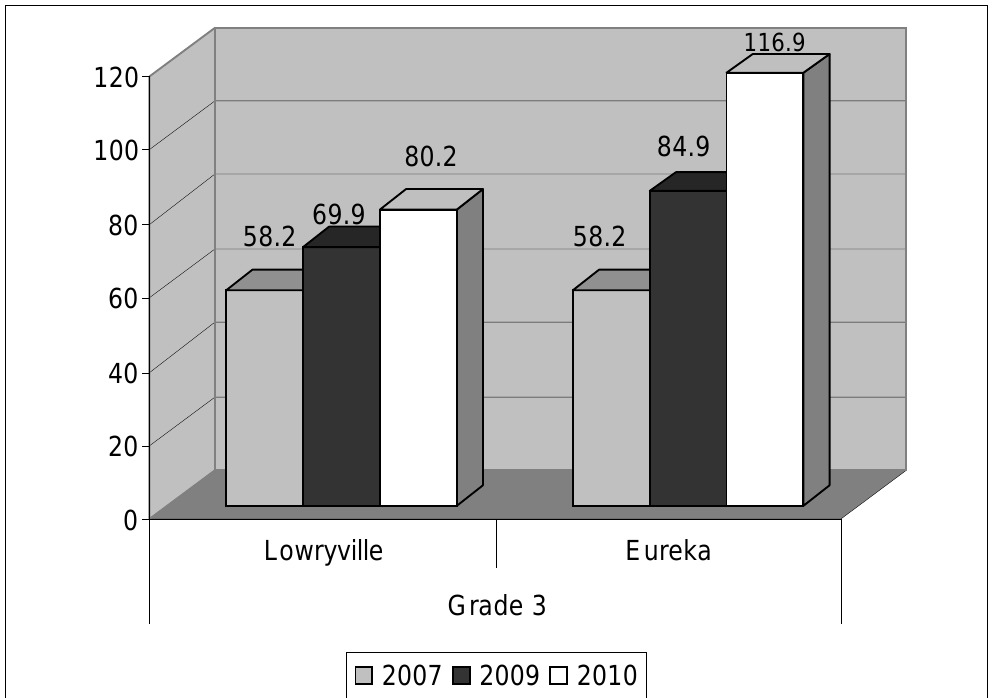
Figure 6 Mean Scholastic Scores for Grade Three: 2007, 2009 and